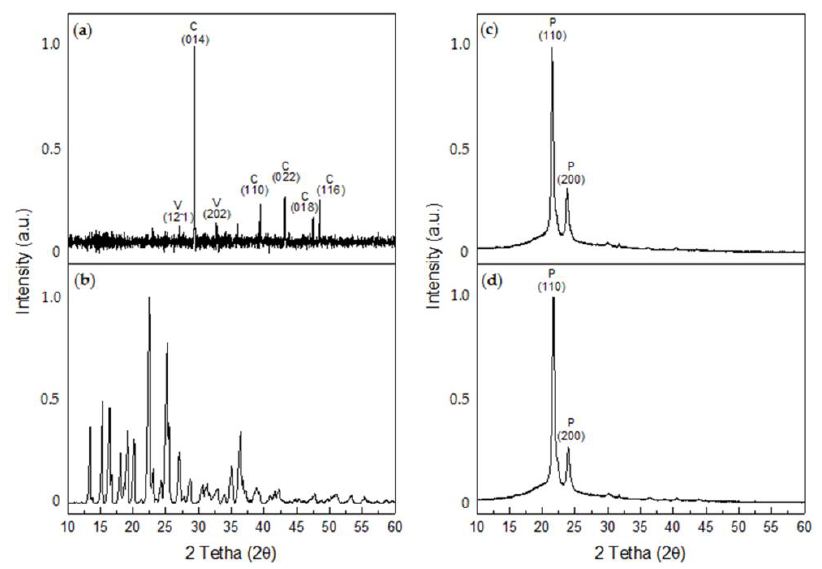
Figure 10. XRD diffractograms. ( a ) CaCO 3 , ( b ) glycine betaine, ( c ) R-P/G0-EPnF, and ( d ) R-P/G2- EPnF. The abbreviations of C, V, and P correspond to calcite, vaterite, and poly (ε -caprolactone), respectively.